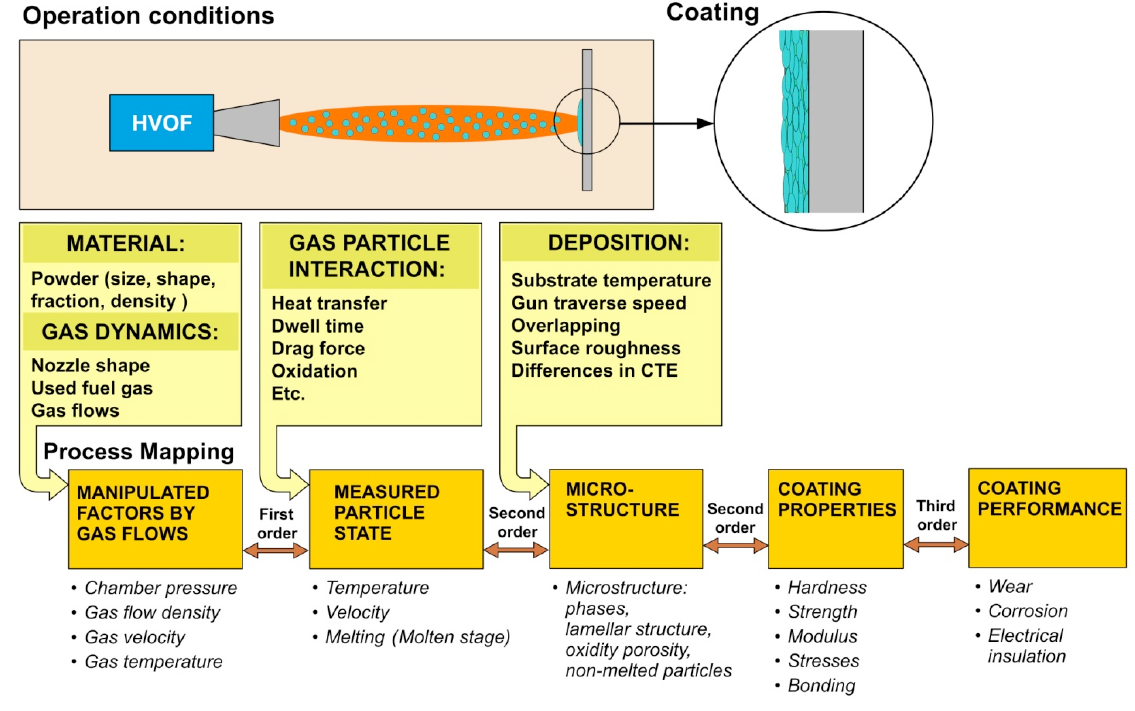
Figure 5. The process map concept for the HVOF process. The relationship between process parameters, measured particle state, coating microstructure and coating properties are described as process maps of different order. The goal of process mapping is to understand the process-structure-properties in order to be able to use the tool for coating